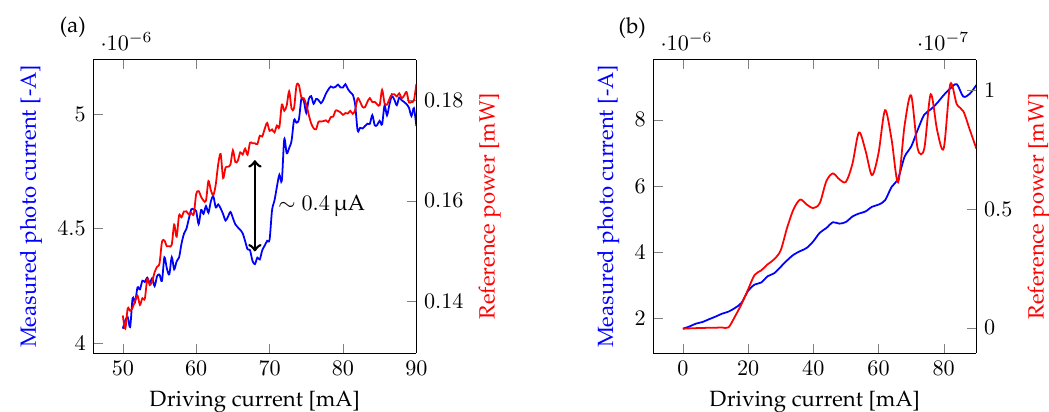
Figure 5. ( a ) blue: Current on on-chip photodetector (PD) red: reference power. ( b ) blue: Current on on-chip PD without fiber coupling. red: Amplitude rise on reference due to coupling into unaligned fiber on laser side. In contrast to other measurements, these curves have been taken at 18 ° C.